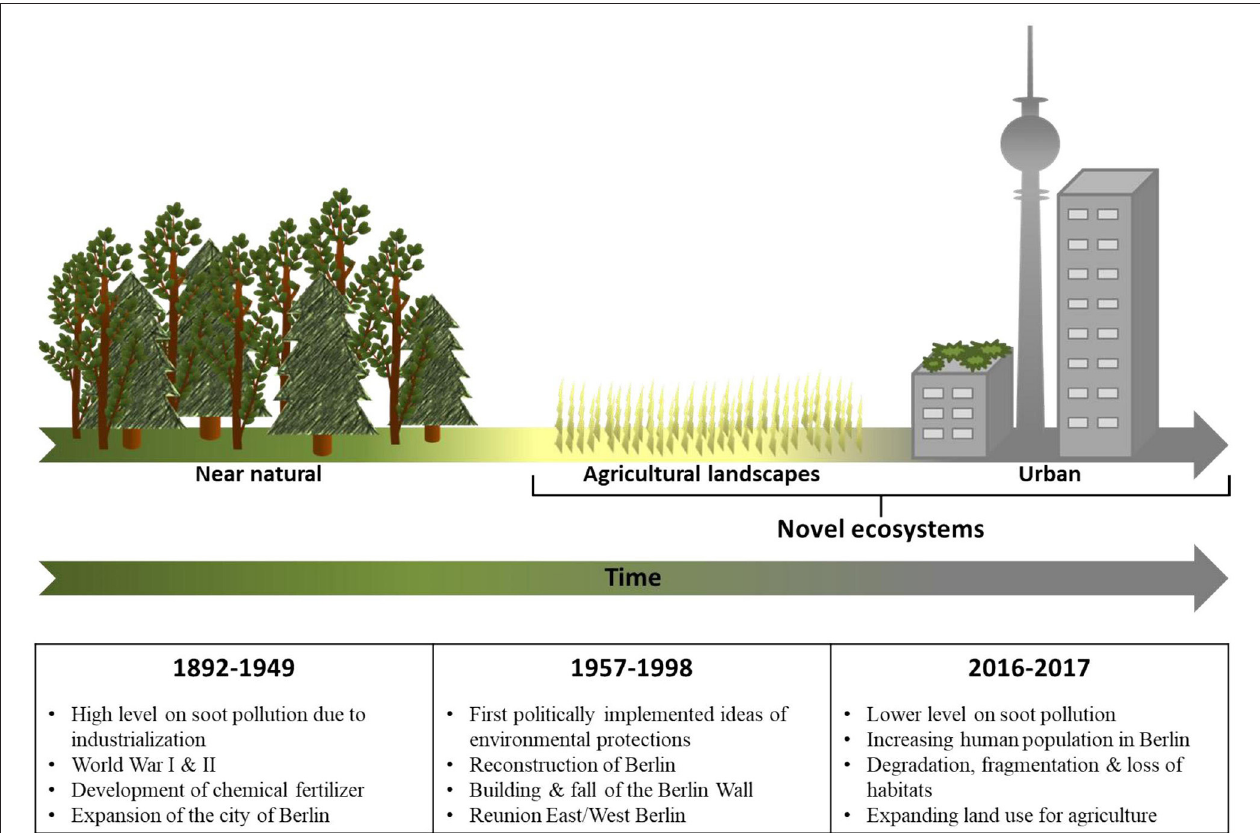
FIGURE 1 | History and anthropogenic impacts on environments in space and time in the German Berlin-Brandenburg area. Different habitat types nowadays in space are reflected over time. Important events influencing environments are connected with the respective time